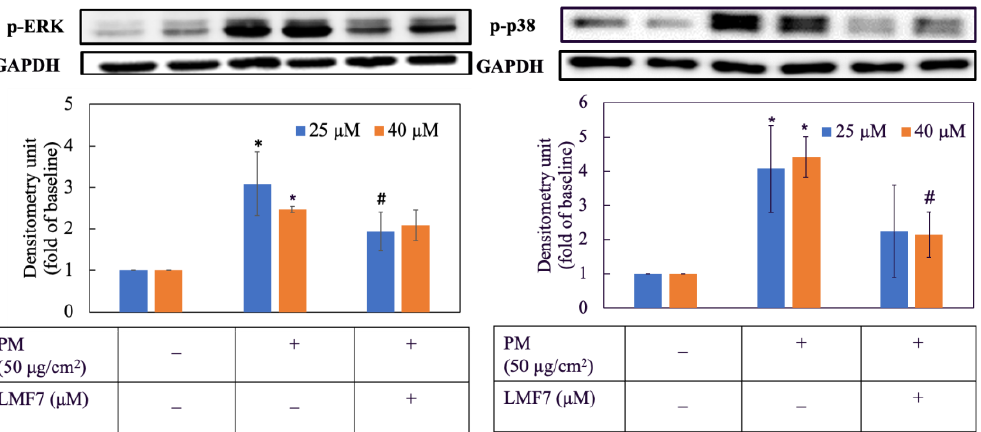
Figure 12. p-ERK and p-p38 protein expression. Cells were pre-incubated with blank liposome or liposomal morin formulation 7 for 3 h and then treated with PM for 2 h. +, − mean with or without exposing to PM or LMF7, respectively. Data were presented as mean ± SD and from triplicate experiments. *, # indicates a statistically significant difference with control group (without treating PM and LMF7) and PM group (only treating LMF7), respectively, p < 0.05.